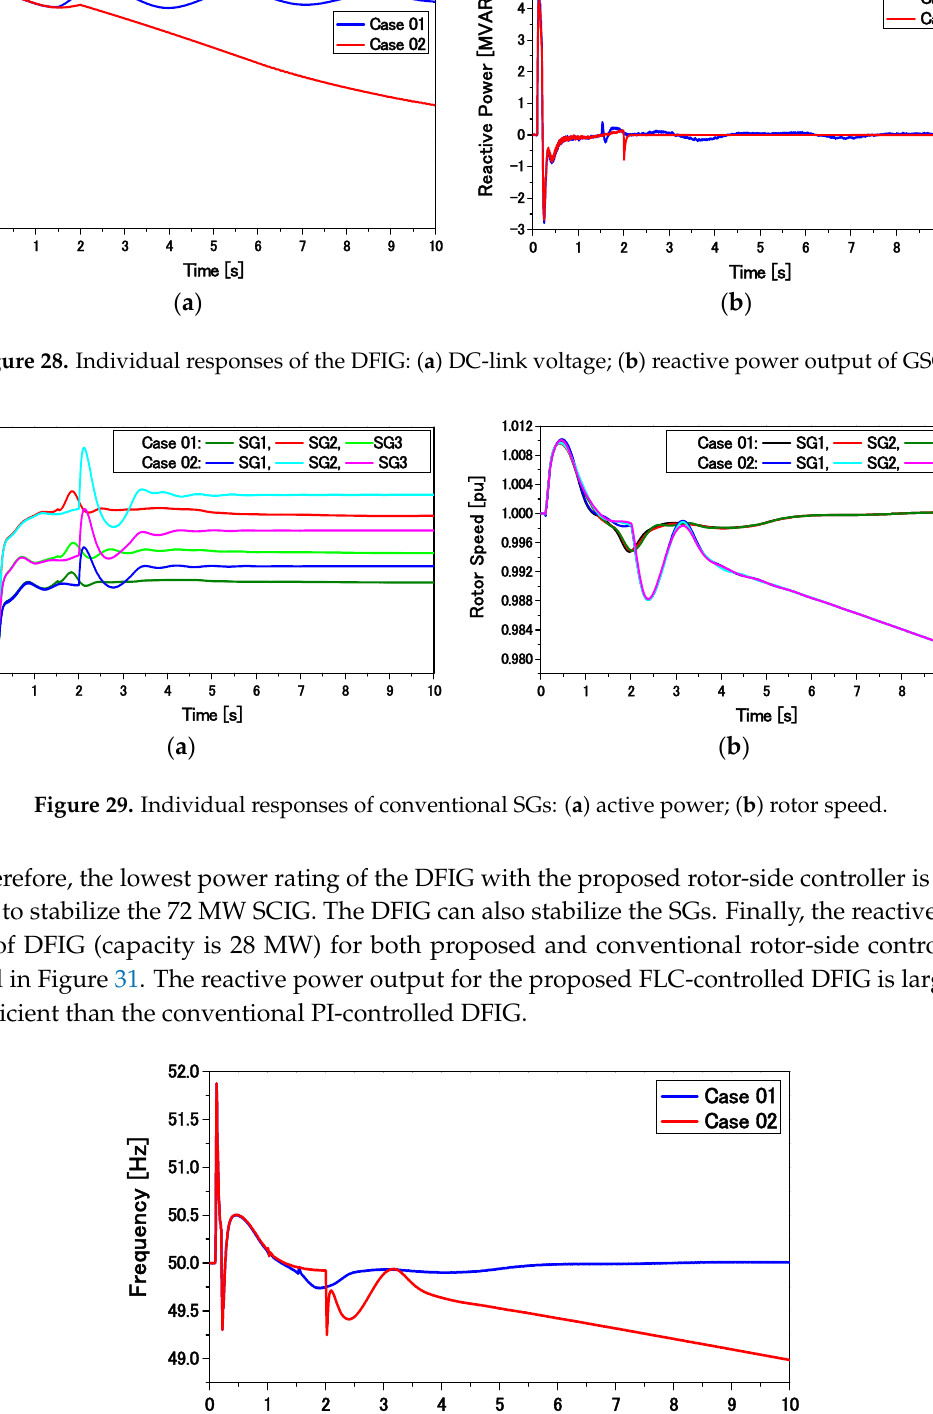
Figure 30. Frequency responses of the power system.